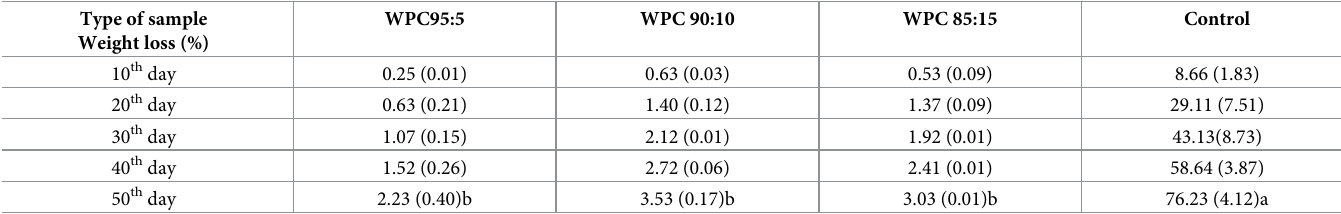
Table 3. Weight loss of the WPC after grave yard test in defined